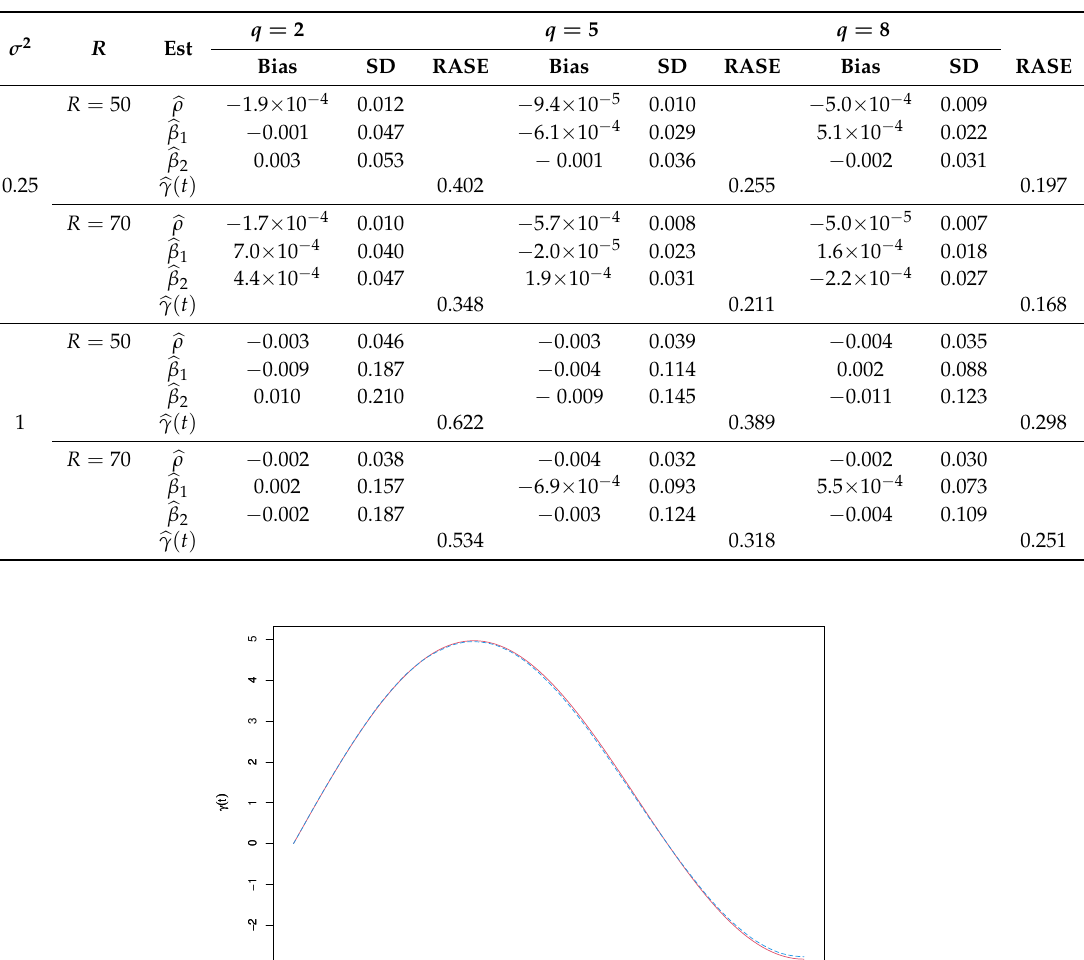
Table 3. Simulation results for ρ = 0.7.